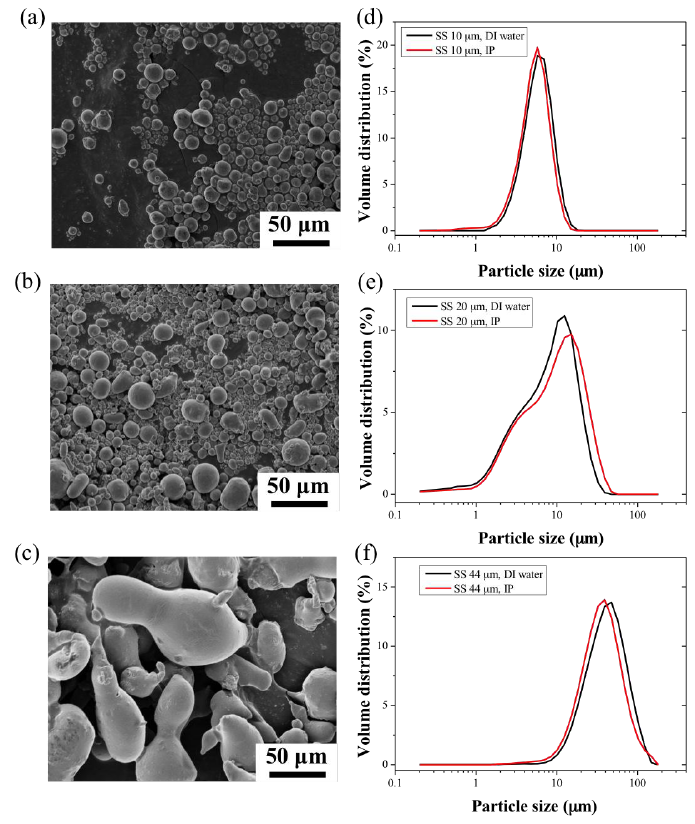
Figure 1. SEM images of ( a ): the 10 µ m stainless steel (SS) powder, ( b ): the 20 µ m SS powder and ( c ): the 44 µ m SS powder. ( d – f ) are their respective size measurements in distilled (DI) water and isopropanol (IP).